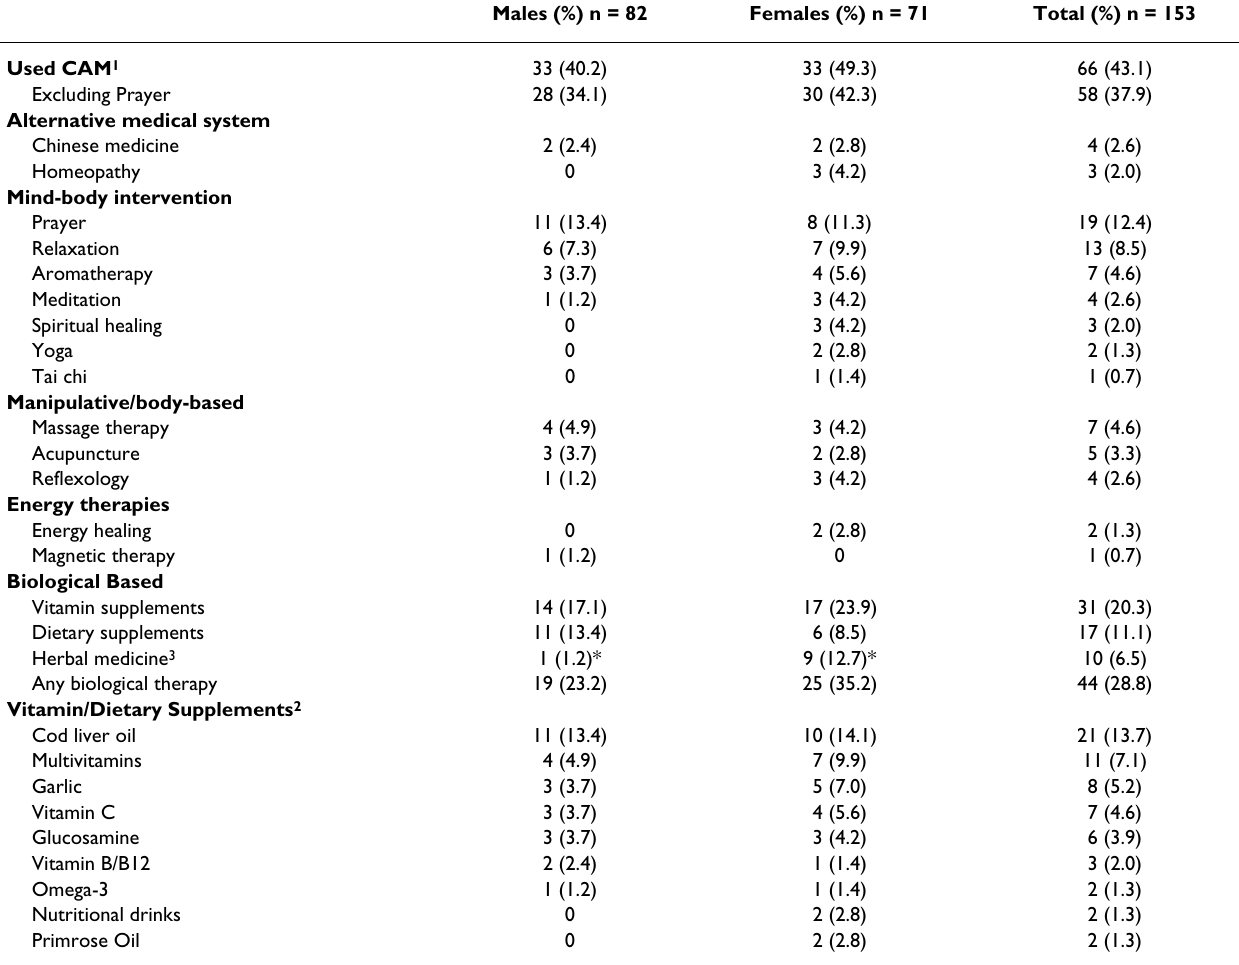
Table 2: Use of CAM, vitamin & dietary supplements, by gender